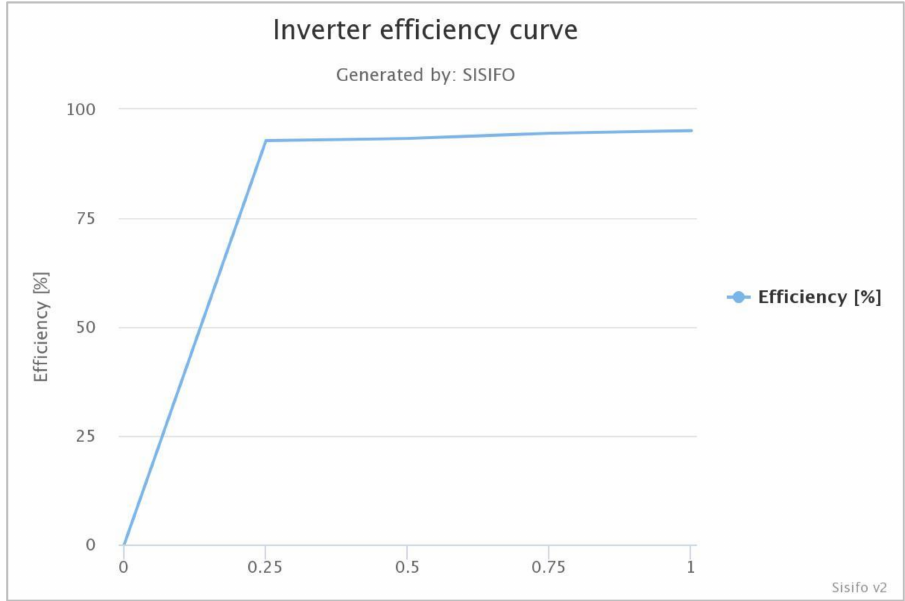
Figure 7. The inverter efficiency depending of the rated output